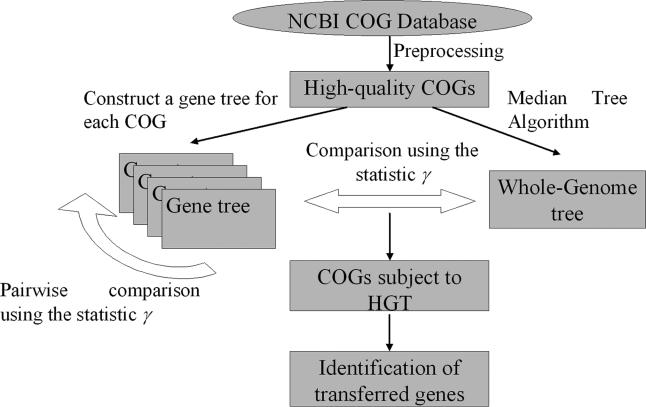
Flowchart of the HGT Inference ProcedureThe National Center for Biotechnology Information COG database is preprocessed for a high-quality COG set. This set is used to construct individual gene trees and the W-G tree, using the median tree algorithm. The gene trees are compared against the W-G tree to detect changes in tree topology that are best explained by a branch transfer. The same comparison is done among all gene trees.